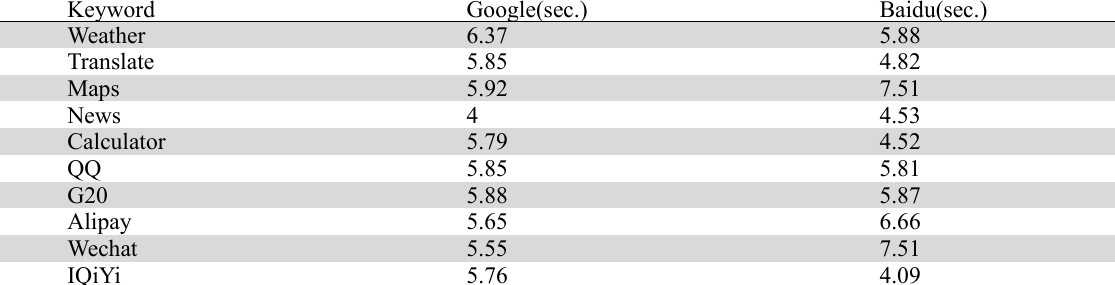
Search completion time in Google and Baidu SEs